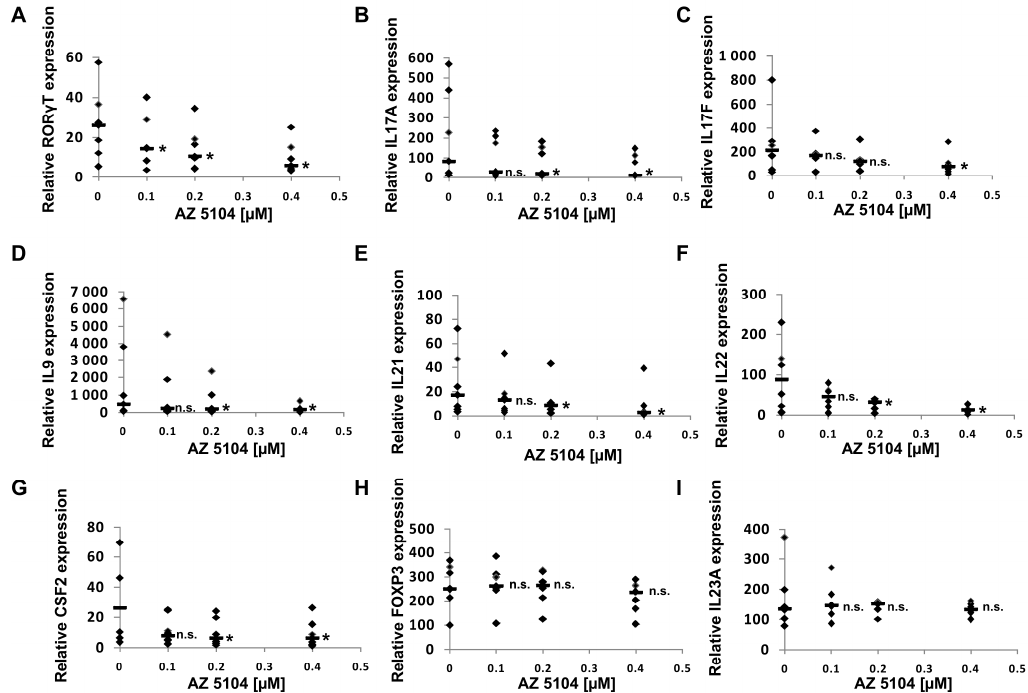
Figure 6. Effect of AZ5104 on the expression of selected genes in human Th17 cells. Naive human CD4+ cells were treated with increasing concentrations of AZ5104 and cultured under Th17 polarizing conditions for 5 days. Then, the cells were collected for RNA extraction. The expression of the ROR γ T ( A ), IL17A ( B ), IL17F ( C ), IL9 ( D ), IL21 ( E ), IL22 ( F ), CSF2 ( G ), FOXP3 ( H ) and IL23A ( I ) genes was determined by real-time RT-PCR. The results were normalized to the housekeeping genes HPRT1 , HMBS, and RPL13A . The data are presented as statistical dot plots with the median value (bars) of seven independent cultures originating from seven different donors ( n = 7), * p < 0.05 compared with control; n.s. – not significant.